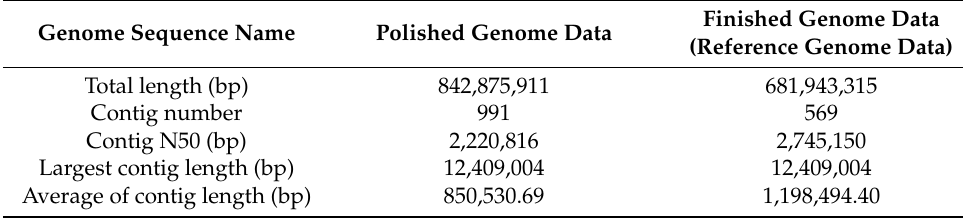
Table 1. The status of the constructed genome sequence data *.